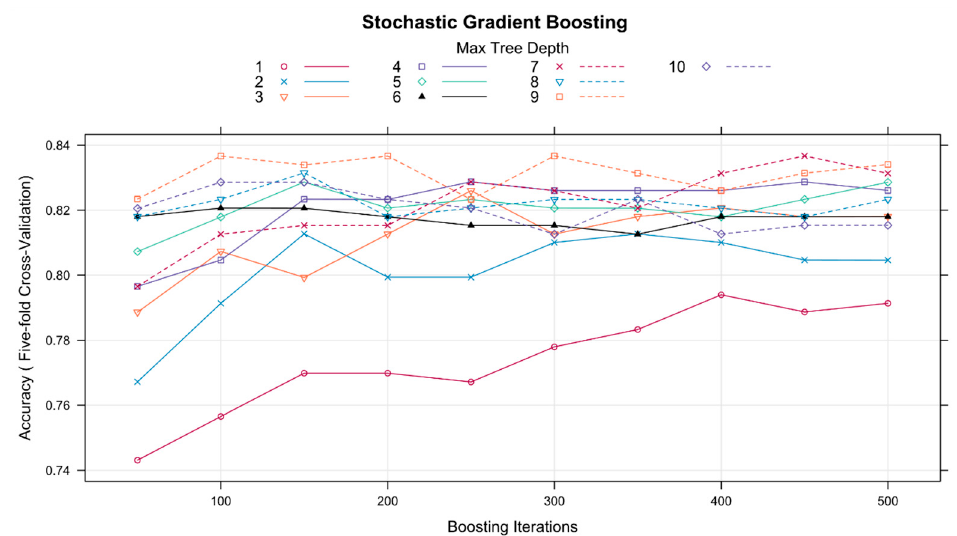
Figure 8. Accuracy variation by tuning parameter profiles (shows partial view) for the eXtreme Gradient Boosting model using the meteorological dataset [2]. The optimal model used the hyperparameters shown in Table 4.